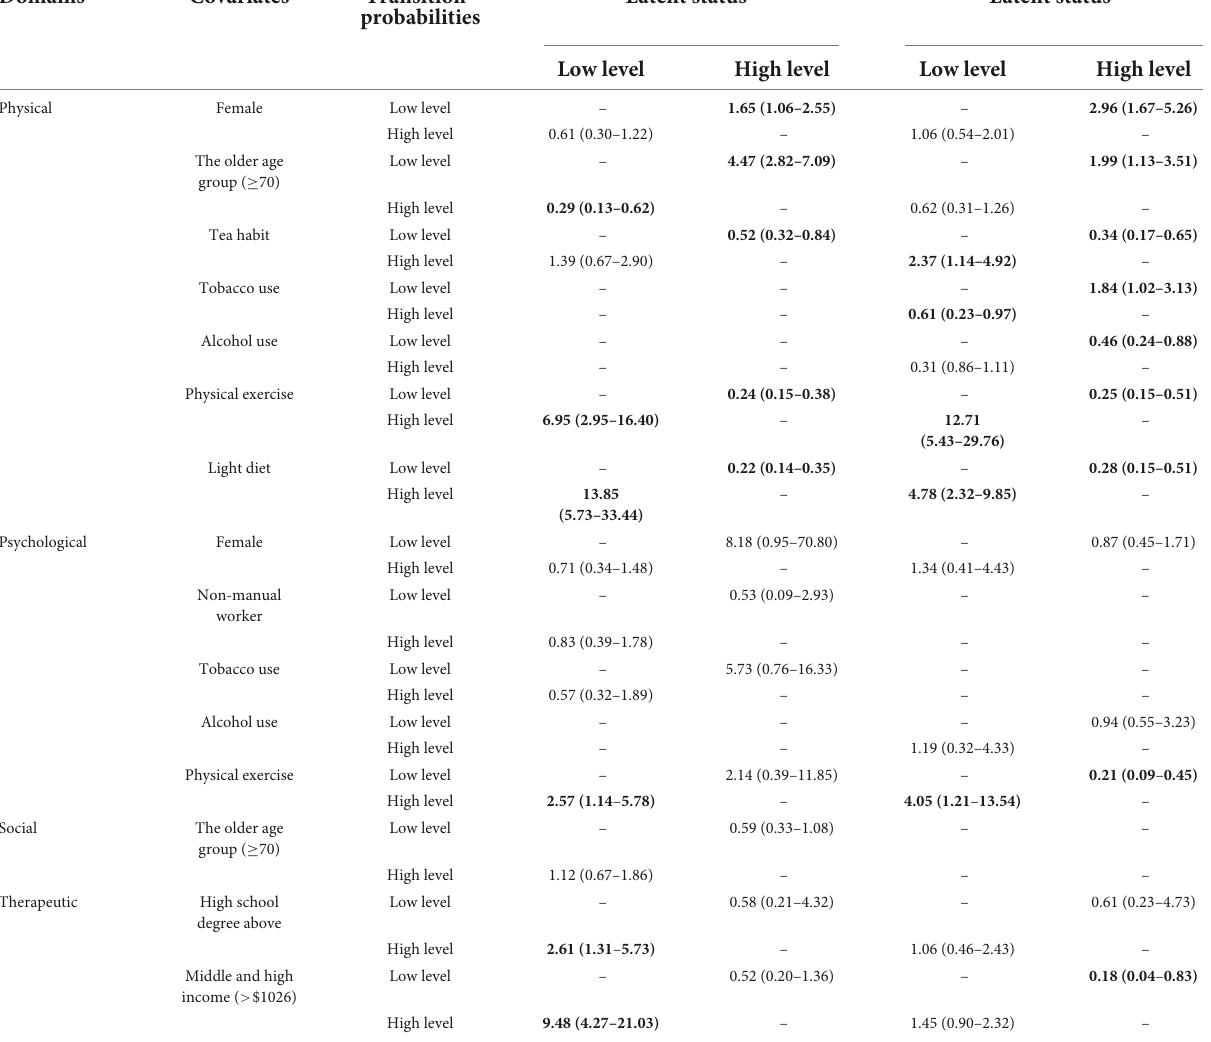
TABLE 2 Odds ratios for covariates predicting transitions between latent statuses of different levels.